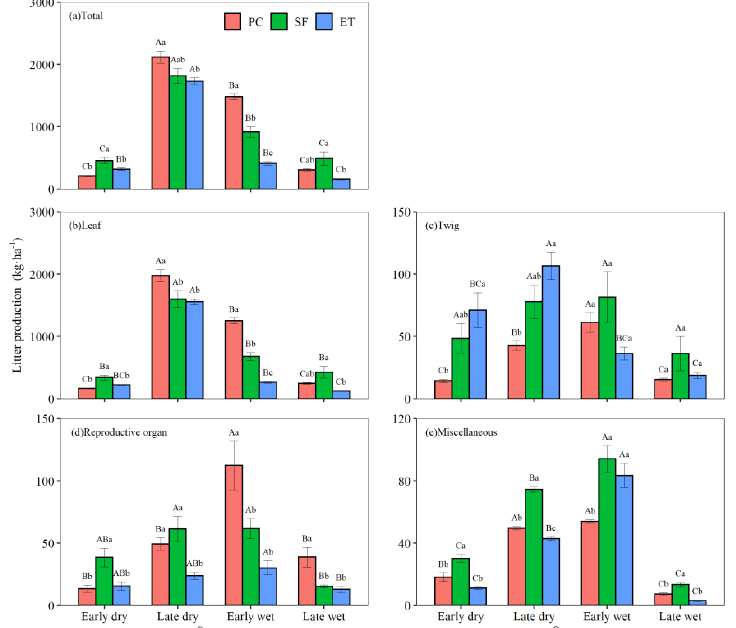
Figure 4. Seasonal production of total litterfall ( a ) and its components (( b ) leaf litter; ( c ) twig litter; ( d ) reproductive organ litter; ( e ) miscellaneous litter) in different plantations. PC: pure cypress; SF: strip filling; ET: ecological thinning. Capital letters indicate differences among seasons within the same plantation, while lowercase letters indicate differences among the three plantations within the same seasons at the p < 0.05 level.